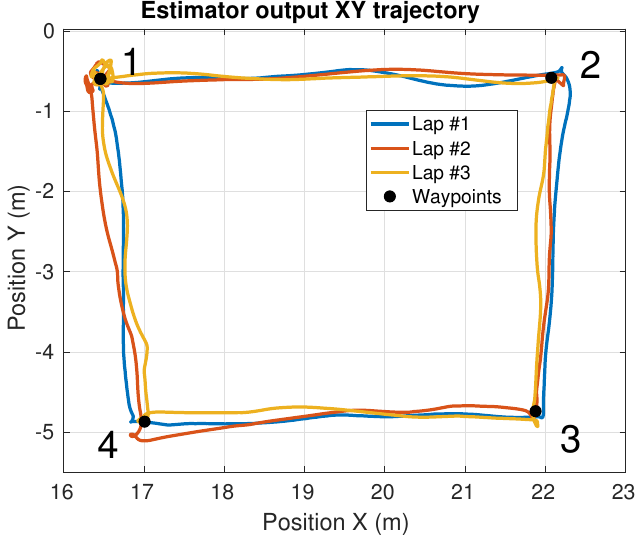
Figure 6. Top view of the estimated UAV trajectory during Experiment 1. The four inspection waypoints are indicated, and each lap is represented with a different color.